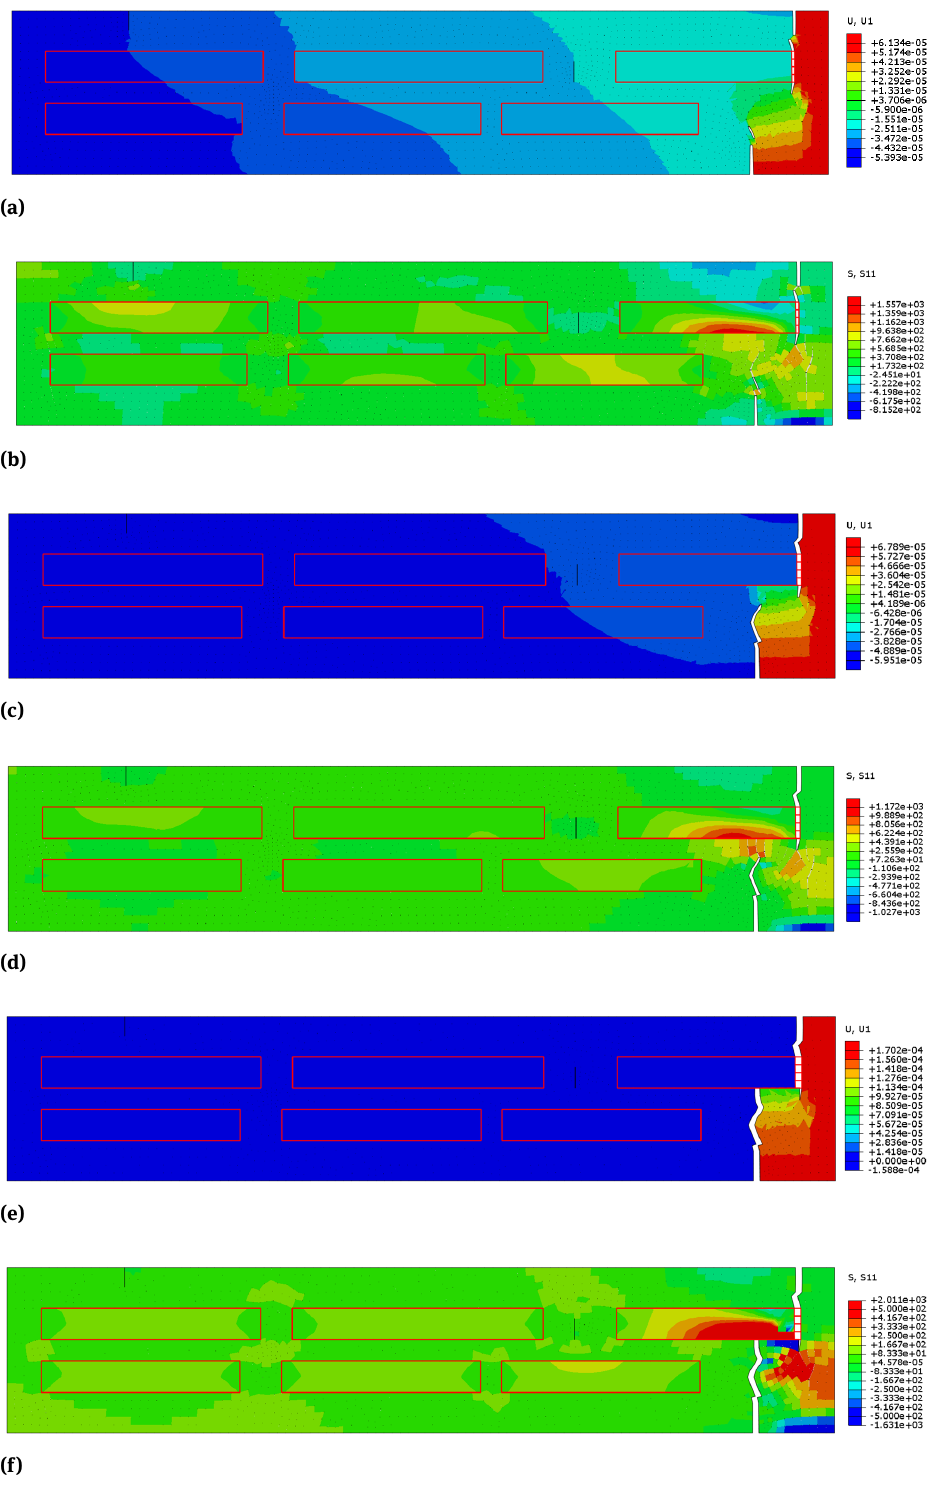
Figure 12: (a) (c) (e) displacement and (b) (d) (f) stress contour figures of the outer region of the cortical bone, in the cohesive FEM cracking simulation under uniform-speed displacement tension load along U1